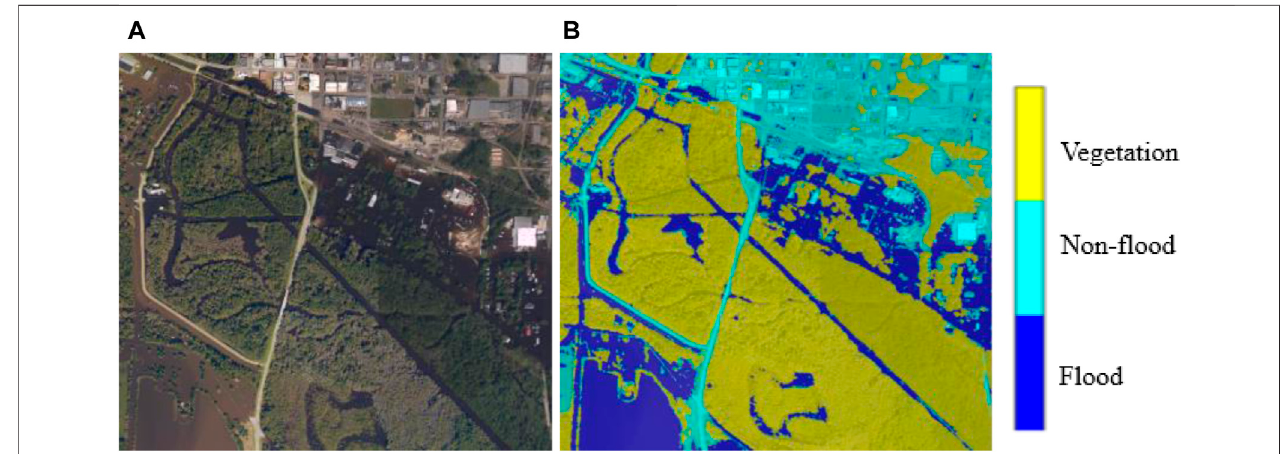
FIGURE 6 | One sample fl ood extent map result. (A) Test image; (B) Flood extent map.